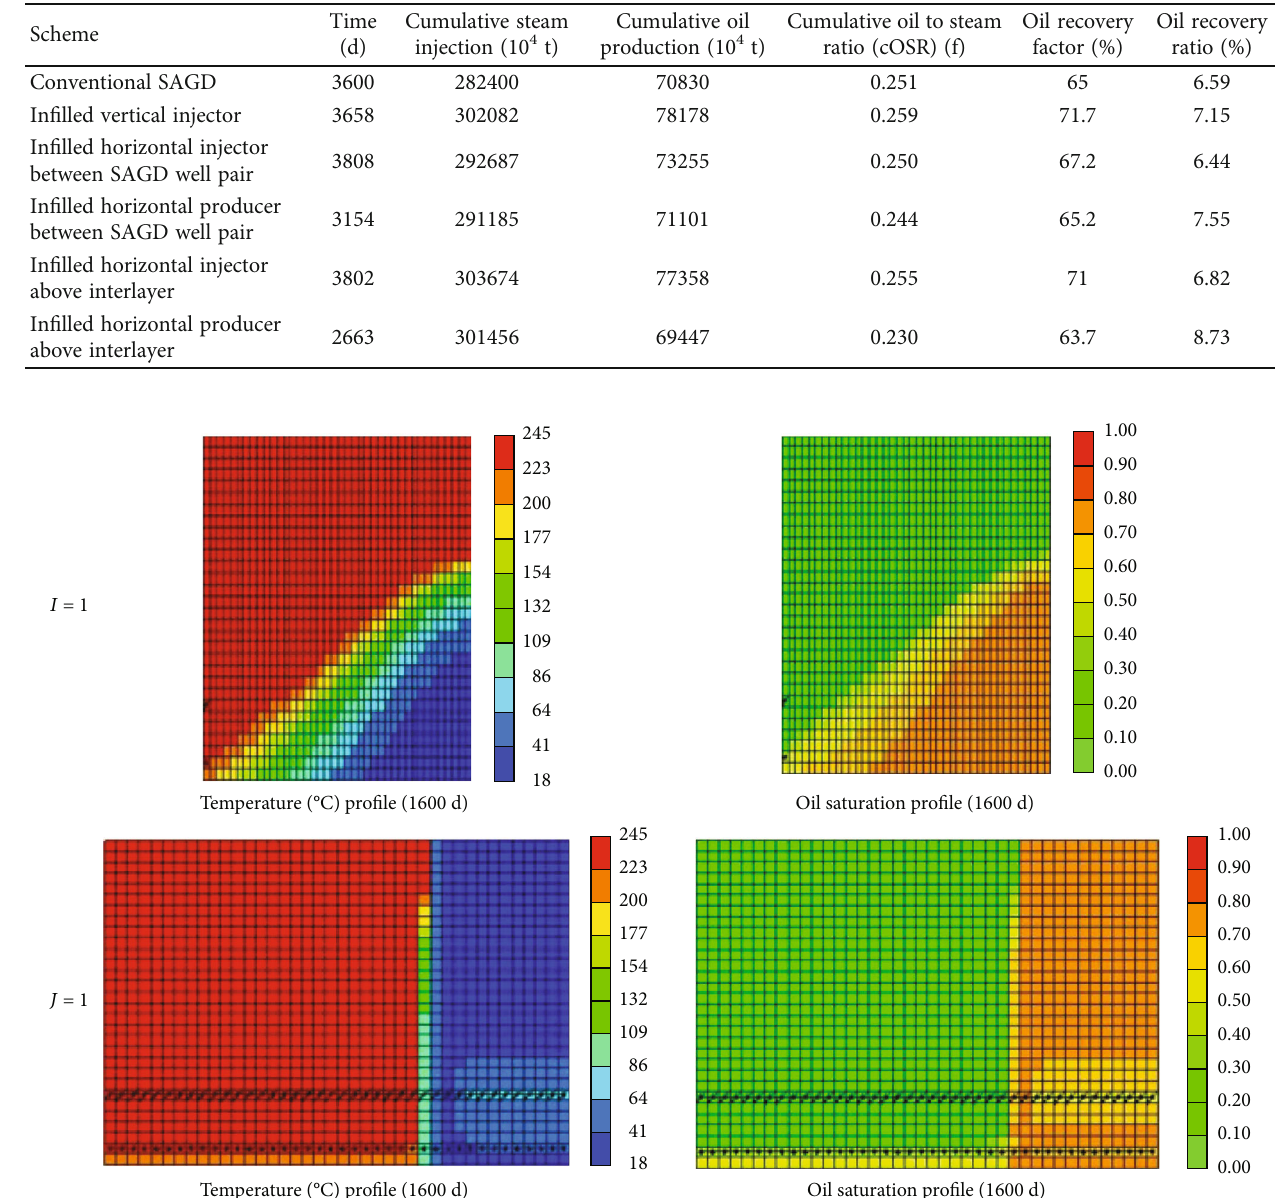
Figure 11: Temperature pro fi le and oil saturation pro fi le for model C.